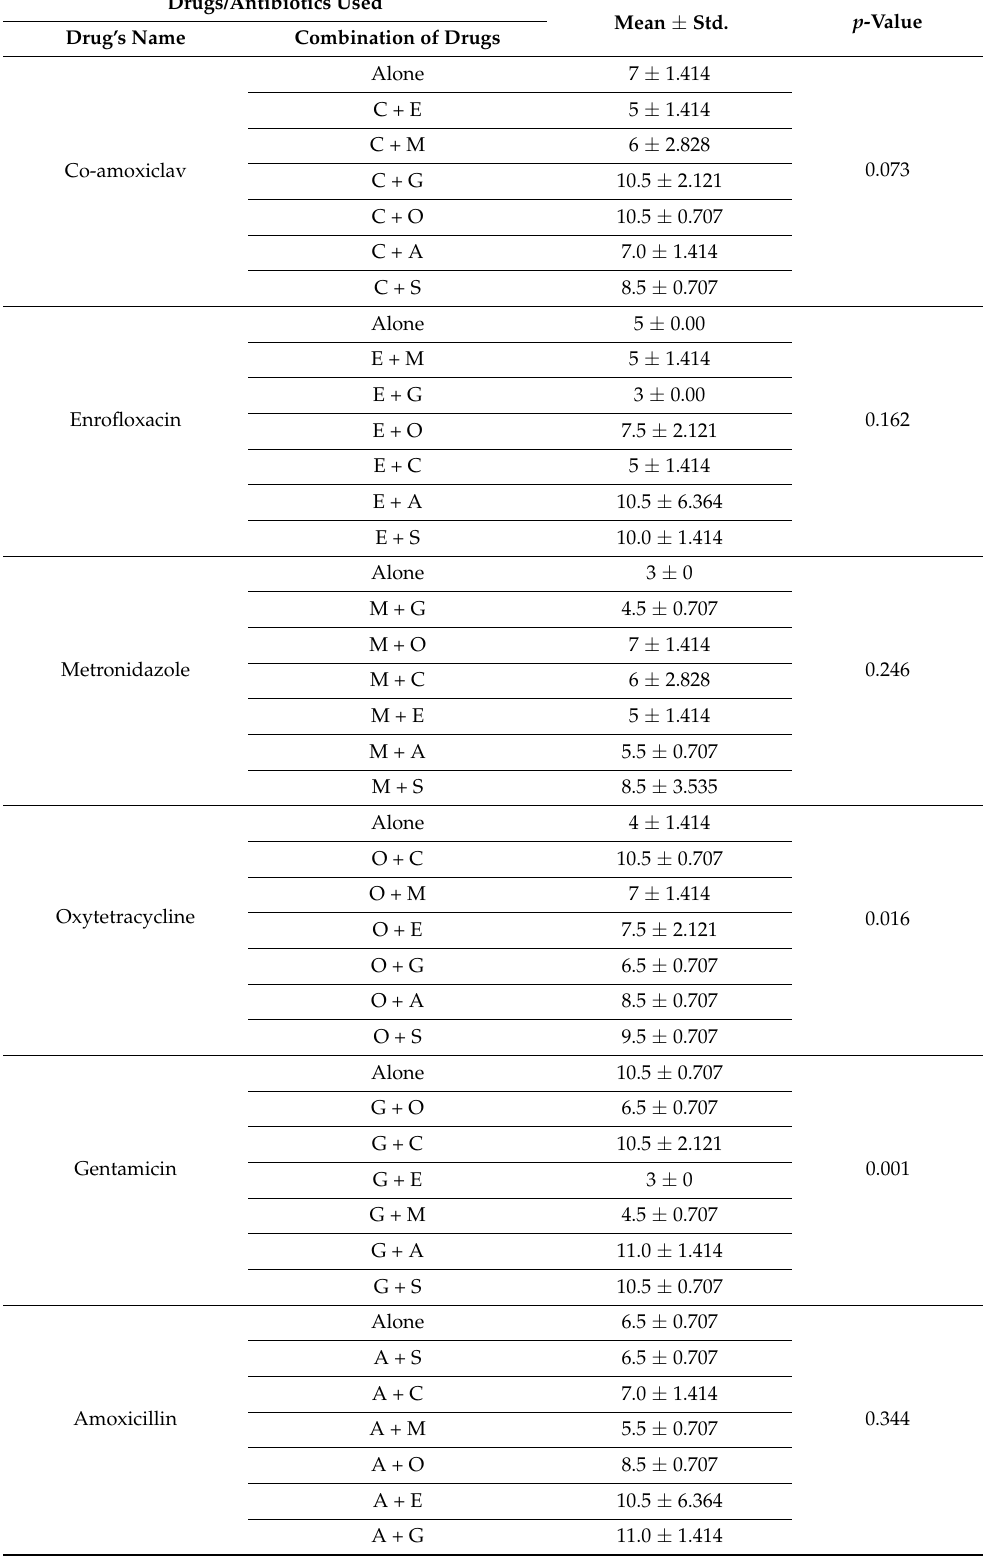
Table 4. Comparison of zones of inhibitions (mm) of E. coli isolates against different combinations of